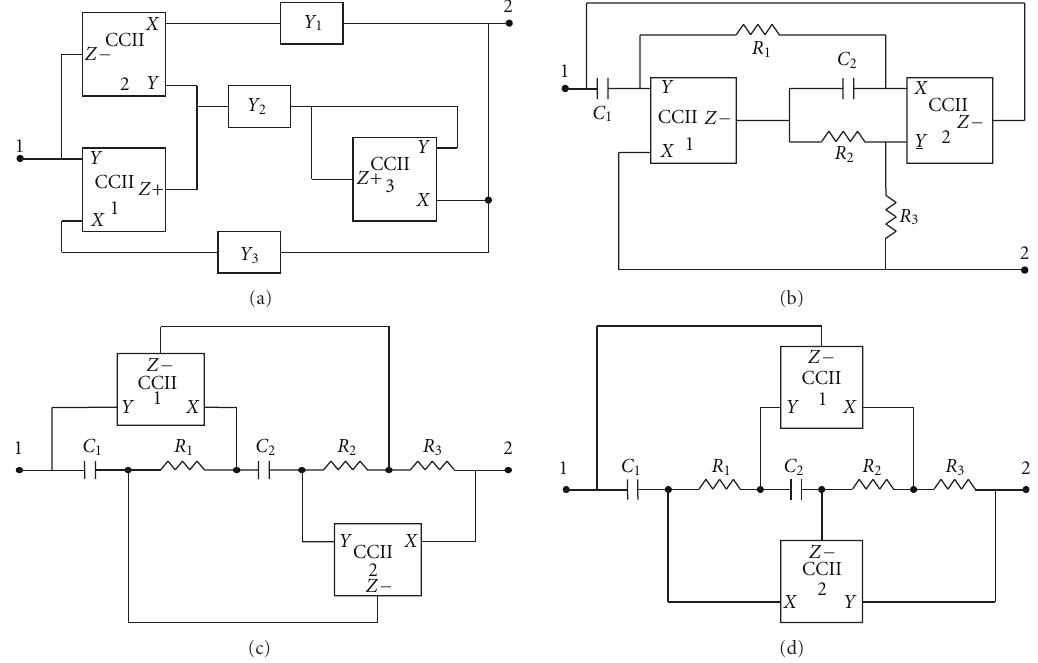
Figure 3: (a) Floating inductor circuit proposed in [11]. (b) Floating FDNR circuit proposed in [13]. (c) Floating FDNR circuit proposed in [14]. (d) Floating FDNR circuit proposed in